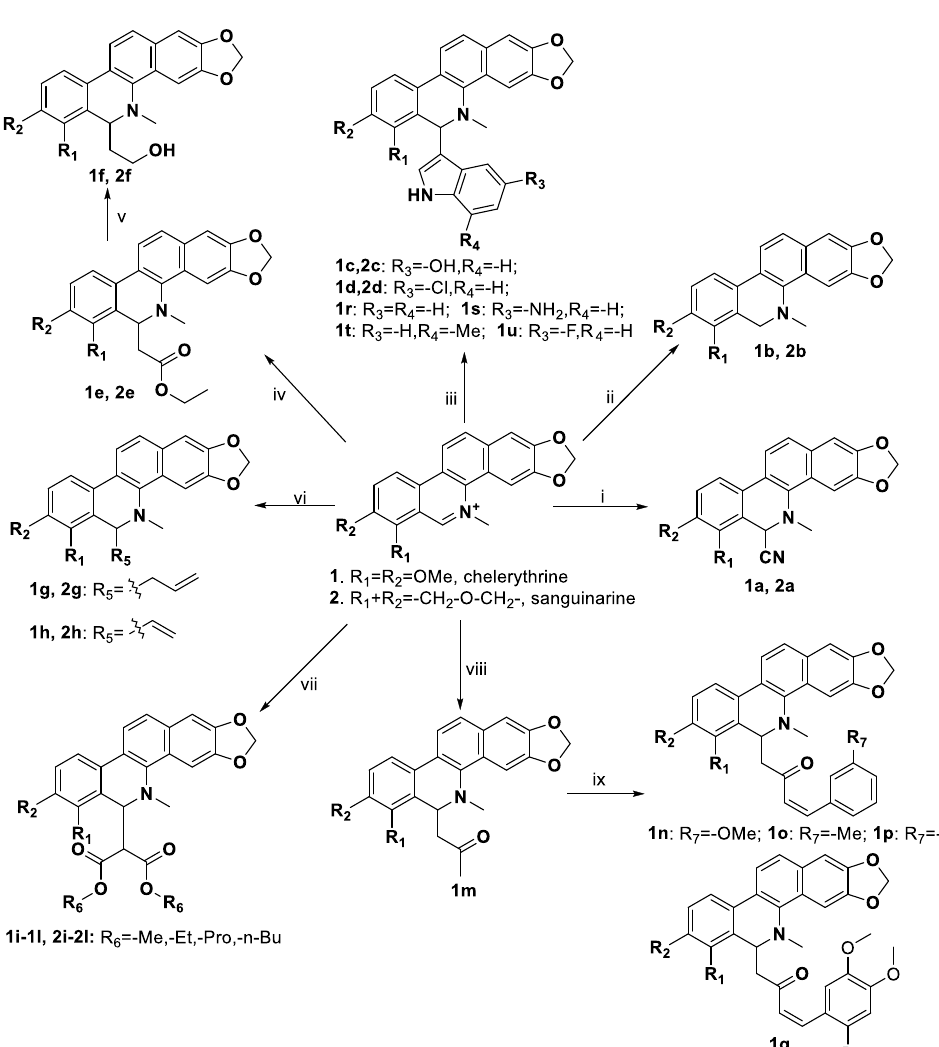
Figure 2. Reagents and reaction conditions: ( i ) TMSCN, DMAP, DCM, reflux, 14 h; ( ii ) NaBH